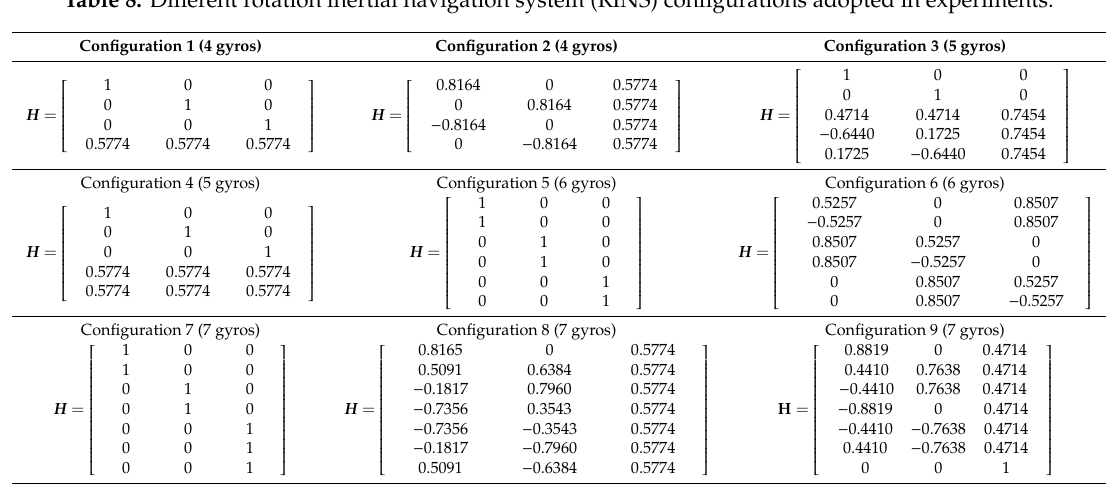
Table 8. Di ff erent rotation inertial navigation system (RINS) configurations adopted in experiments.